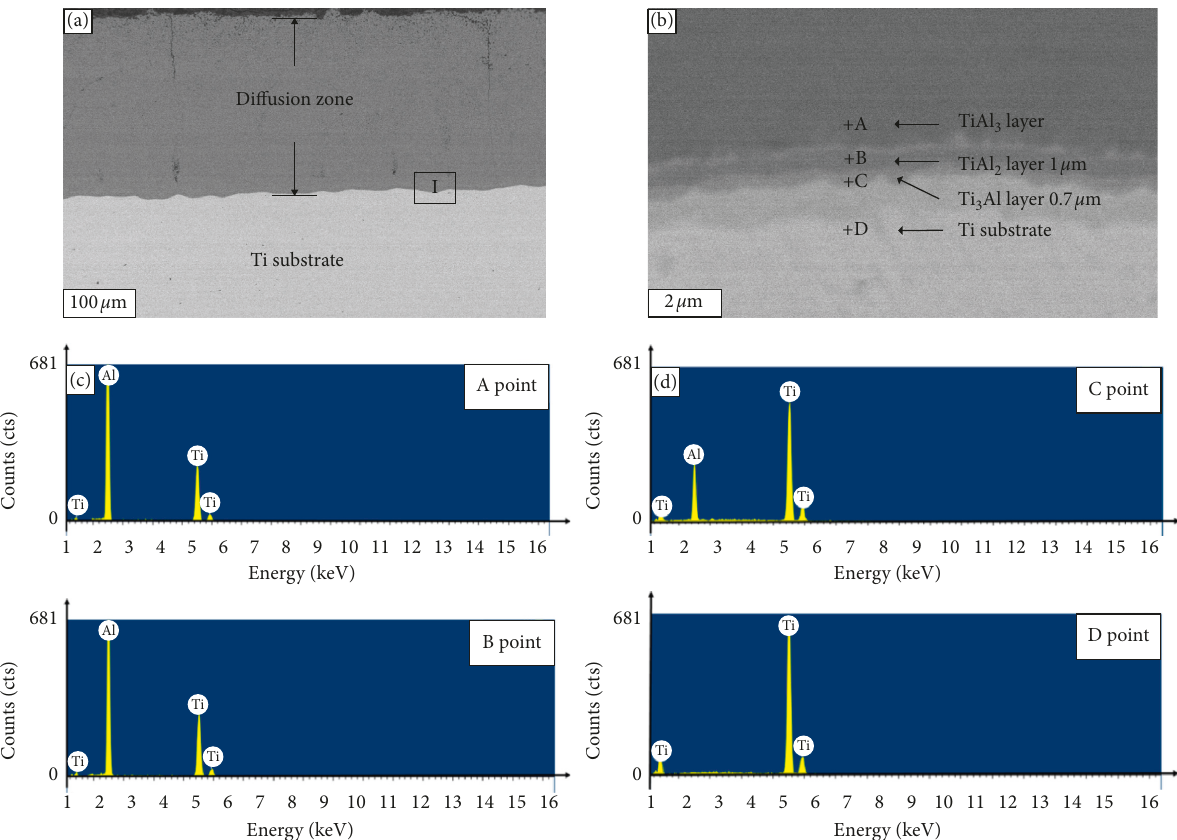
Figure 6: (a) Cross-sectional BSD image of Al coating after testing for 5 hours at 1073 K, (b) the expanded view of region I in Figure